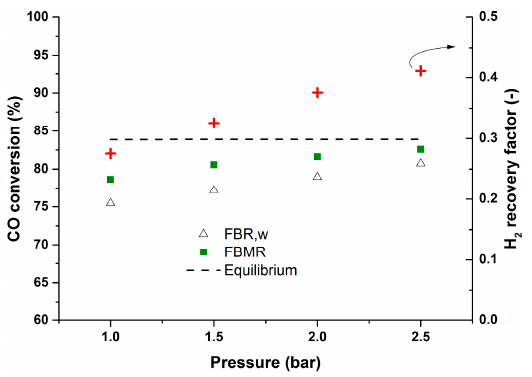
Figure 8. Membrane reactor performance at different pressures up to 2.5 bar and at 400 °C, CO (5%), H 2 O (15%), CH 4 (0%), H 2 (18%), N 2 balance, U/U mf :1.71–6, P permeate : 30 mbar.